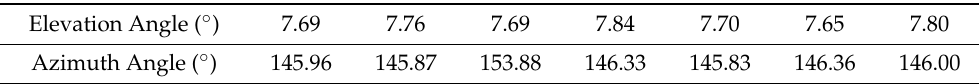
Table 16. DOA estimation by CPCMA-ESPRIT for outer race fault signal at 725 rpm.